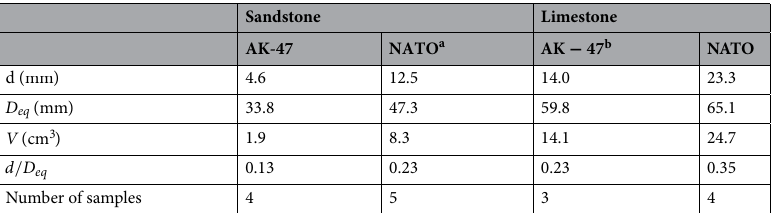
Table 1. Summary of average depth ( d ), diameter ( D eq ), measured volume ( V ), and depth/diameter ratio for targets of Stoneraise Red Sandstone and Cotswold Hill Cream Limestone shot with 7.62x 39 mm (AK-47) a and 5.56x 45 mm NATO projectiles. Averages do not include sample SRS_23 which had an impact velocity 3 considerably faster than other samples. For SRS_23: d = 17.5mm , D eq = 68.5mm , V = 24.6cm , d / D eq = b 0.25. Averages do not include sample CHCL_09 which had an impact velocity considerably faster than other 3 samples. For CHCL_09: d = 42.5mm , D eq = 102.2 mm , V = 107.6 cm , d / D eq =